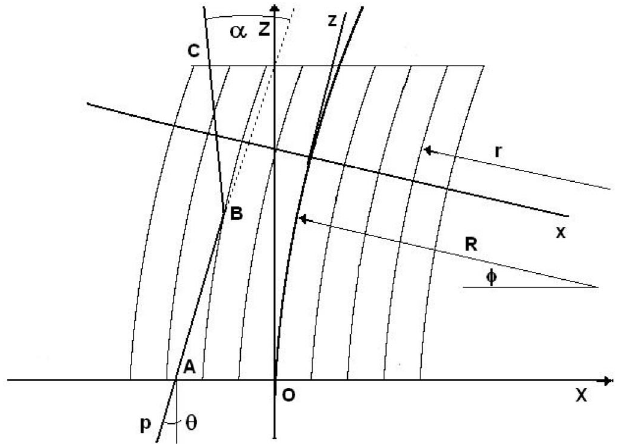
FIG. 1. Scheme of the volume reflection process. XYZ is the Cartesian coordinate system at the entrance in a single crystal, xyz is the local Cartesian coordinate system connected with the current location of a particle. The Y -axis is directed normally to the plane of the figure. (cid:4) and (cid:5) are the initial and volume reflection angles. AB and BC lines are the incoming and out- going directions of a